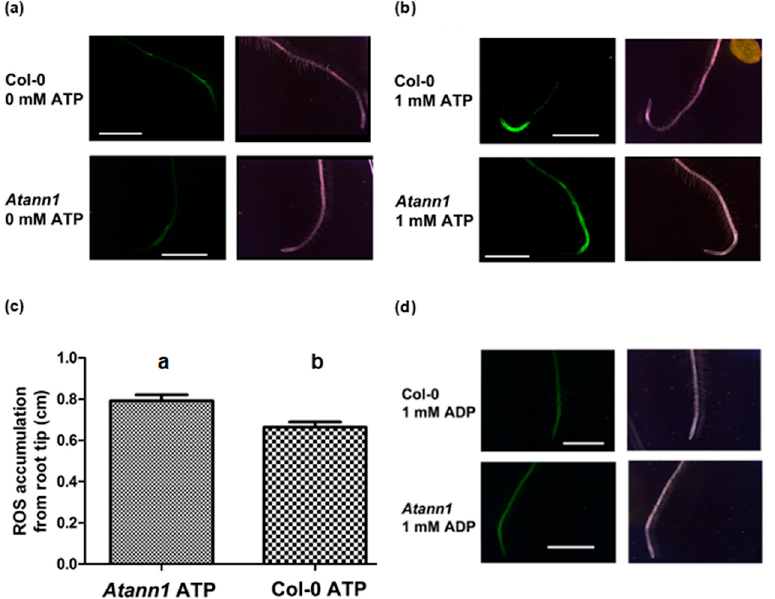
Figure 5. Atann1 supports a longer zone of intracellular ROS accumulation than Col-0 in response to eATP. ( a ) CM-H 2 DCFDA fluorescence from a Col-0 or Atann1 root under control conditions. Corresponding bright field images are also shown. ( b ) Roots after exposure to 1 mM eATP. ( c ) Mean (± SEM) length of root from the tip fluorescing after exposure to eATP (Col-0 n = 48; Atann1 n = 68; p = 0.0026, Student’s t -test). ( d ) Roots after exposure to 1 mM eADP. Scale bar = 4 mm. Different lower-case letters indicate a significant difference between means ( p < 0.05).